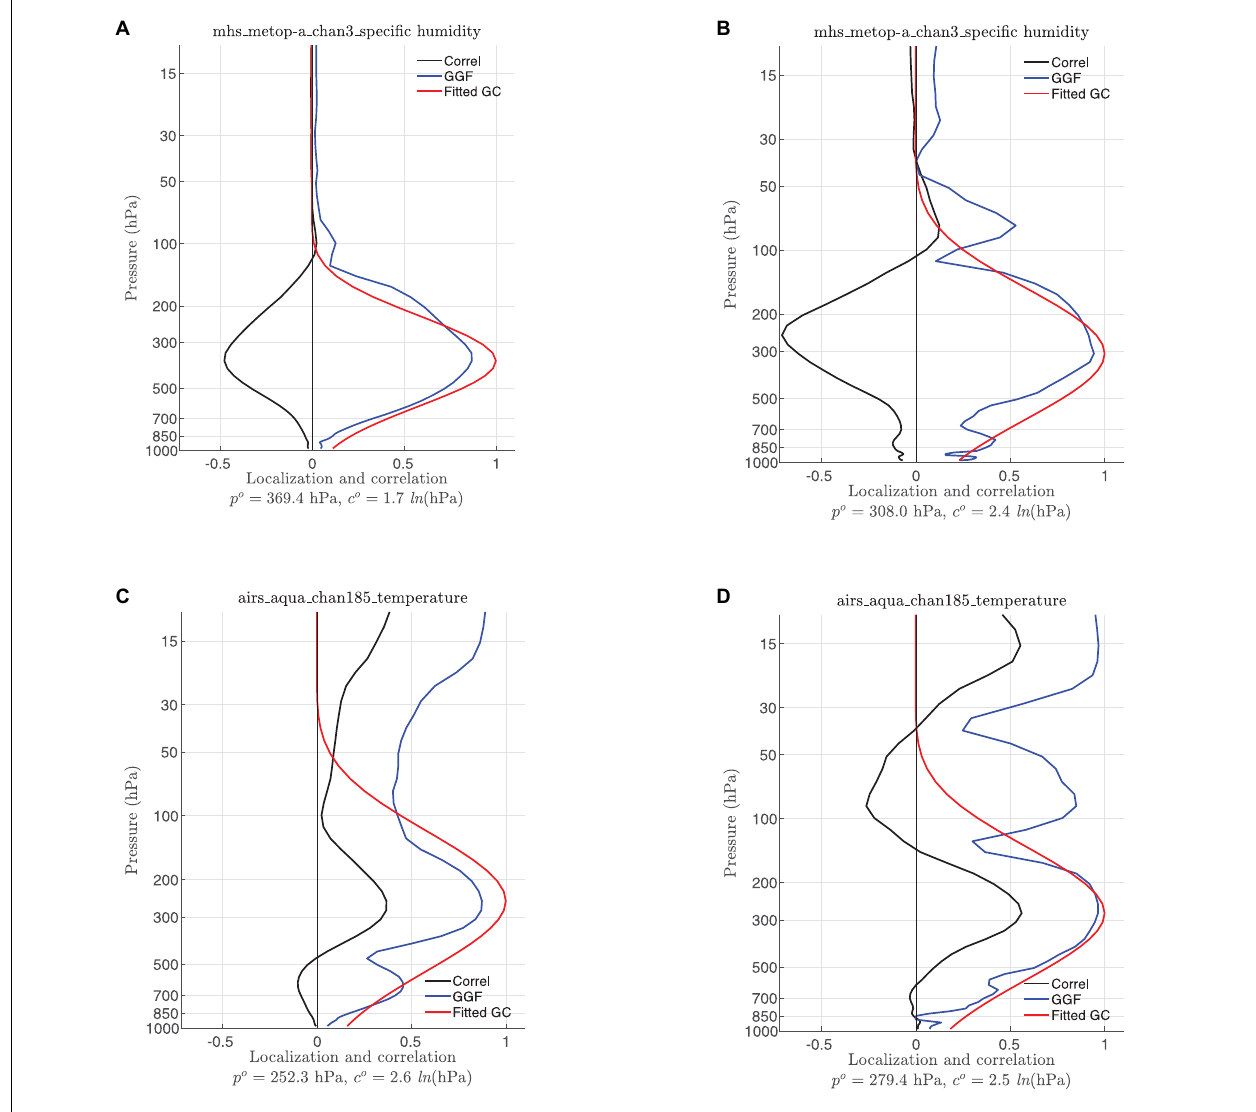
Table 1 , experiment GGF-Domain utilizes constant localization parameters through time and space. Experiment GGF-TC has temporally invariant localization parameters but differing for TC and non-TC regions. Experiment GGF-Time has constant localization parameters over the domain but with temporal variations. State variables of perturbation dry air mass in column, temperature, specific humidity, u- and v-winds are updated by assimilated observations in all experiments. For simplicity and avoiding imbalances, the same set of localization parameters is used for all updated state variables. The GGF localization functions and associated localization parameters for radiance observations of experiments GGF- Domain and GGF-TC are estimated from the output of the CTRL